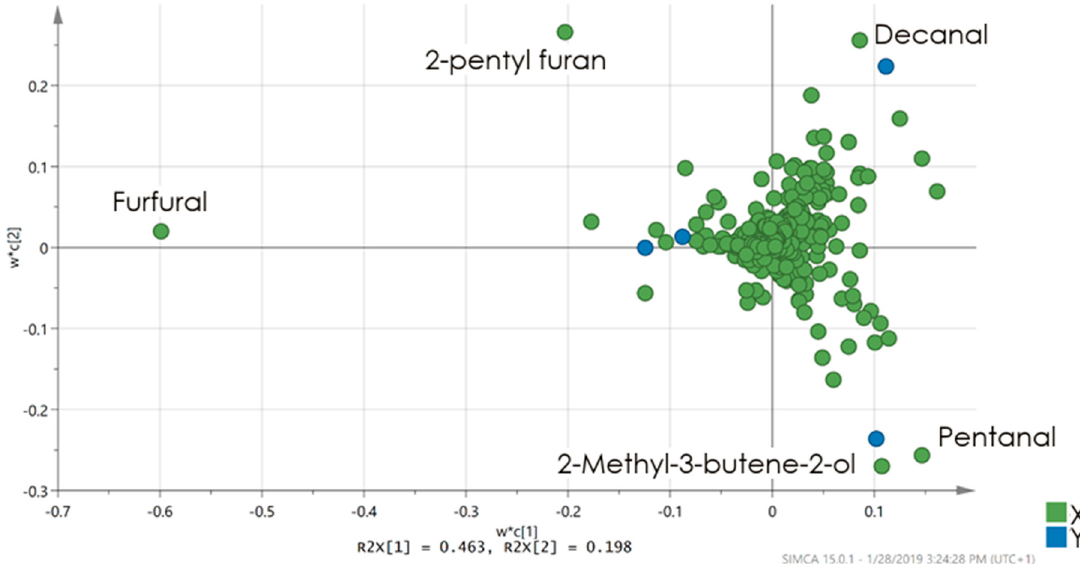
Figure 6. PLS-DA loadings plot presenting significant markers for each treatment. Compounds identification was based on mass spectral similarity and retention index comparison. The identified compounds (pentanal, furfural, 2-pentyl furan, decanal, 2-methyl-3-butene-2-ol) importance is correlating with a distance from the central point; the further the distance, the higher is the markers importance.